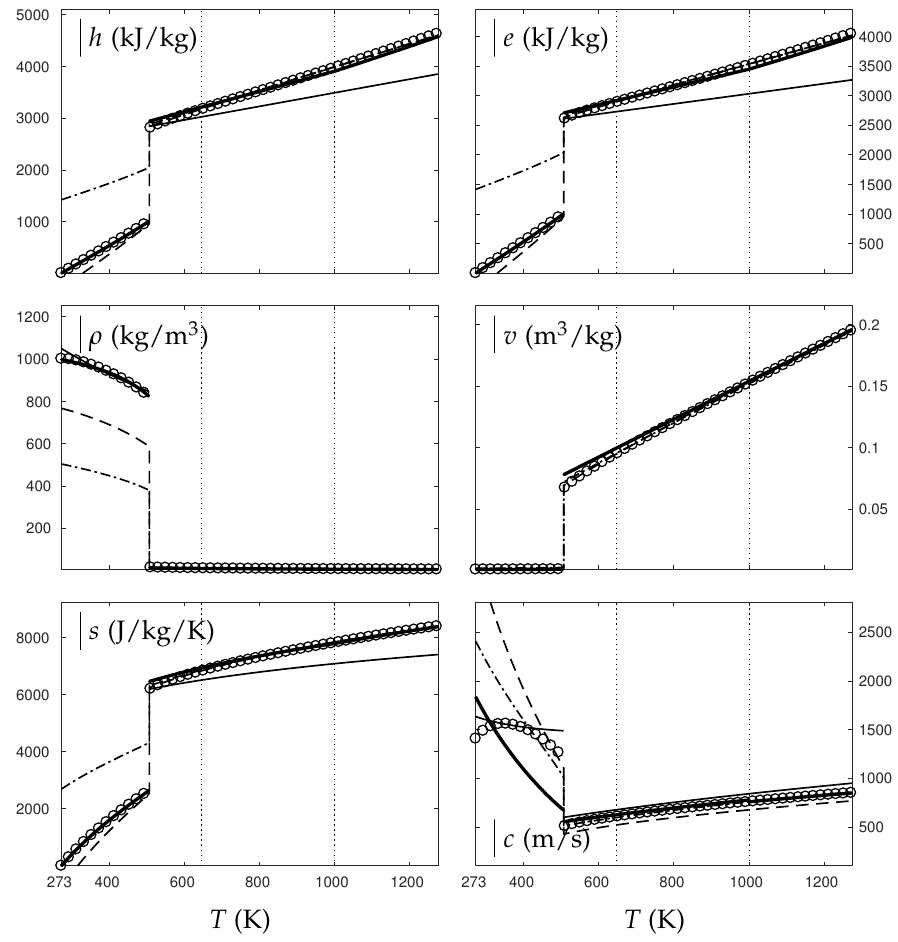
Figure 8. Comparison between experimental and theoretical isobar for water. The symbols represent the experimental isobar p = 30 bars. Beyond the critical temperature T c = 646 K, the vapor transforms to supercritical state. The thick solid lines represent the Extended NASG (ENASG) EOS, reducing to the ideal gas description for vapor and supercritical phases, Equations (56), (57) and (60). The thin solid lines represent the original NASG EOS also reducing to the ideal gas formulation. The dashed-dotted lines represent the van der Waals (VdW) theoretical predictions and the dashed lines represent the Soave–Redlich–Kwong (SRK) ones. The critical temperature is indicated with the dotted lines. The temperature T 0 = 1000 K at which variable heat capacities are considered is indicated in dotted lines as well.